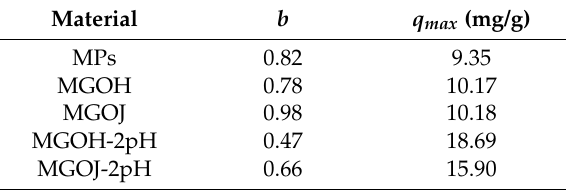
Table 3. Langmuir adsorption isotherm’s parameters for the removal of Se(VI) from its aqueous solution.